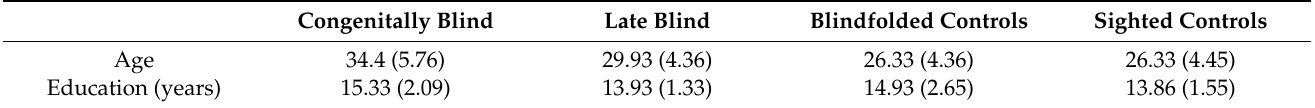
Table 1. Mean (standard deviation in parenthesis) age and education of participants by group. Congenitally